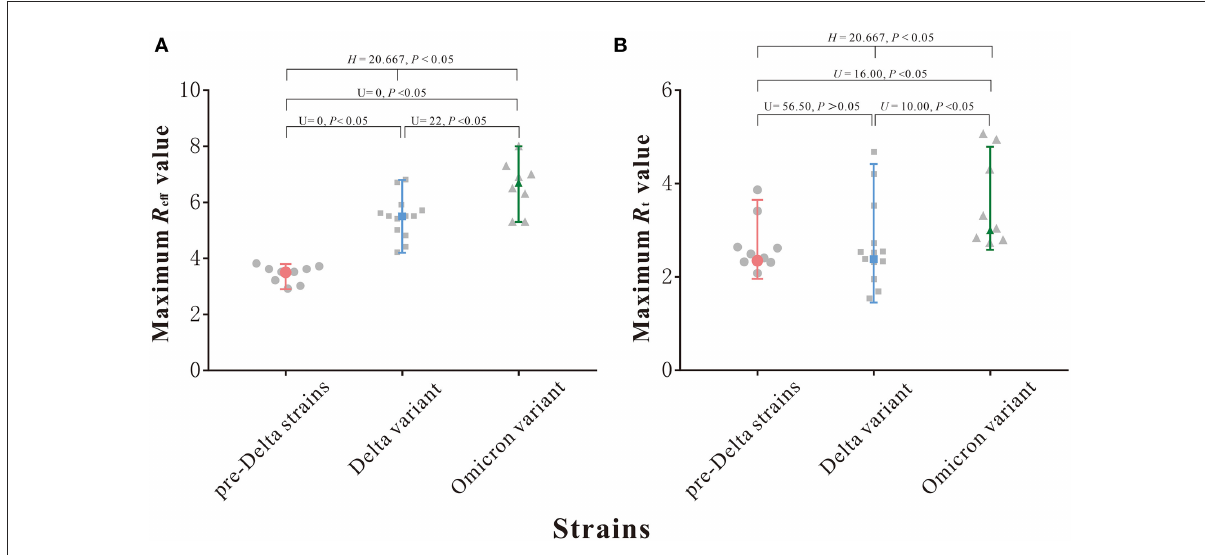
FIGURE3 Maximum R eff and R t value of 9 pre-Delta strains outbreaks and 13 Delta variant outbreaks and 8 Omicron variant outbreaks. (A) Maximum R eff value. (B) Maximum R t